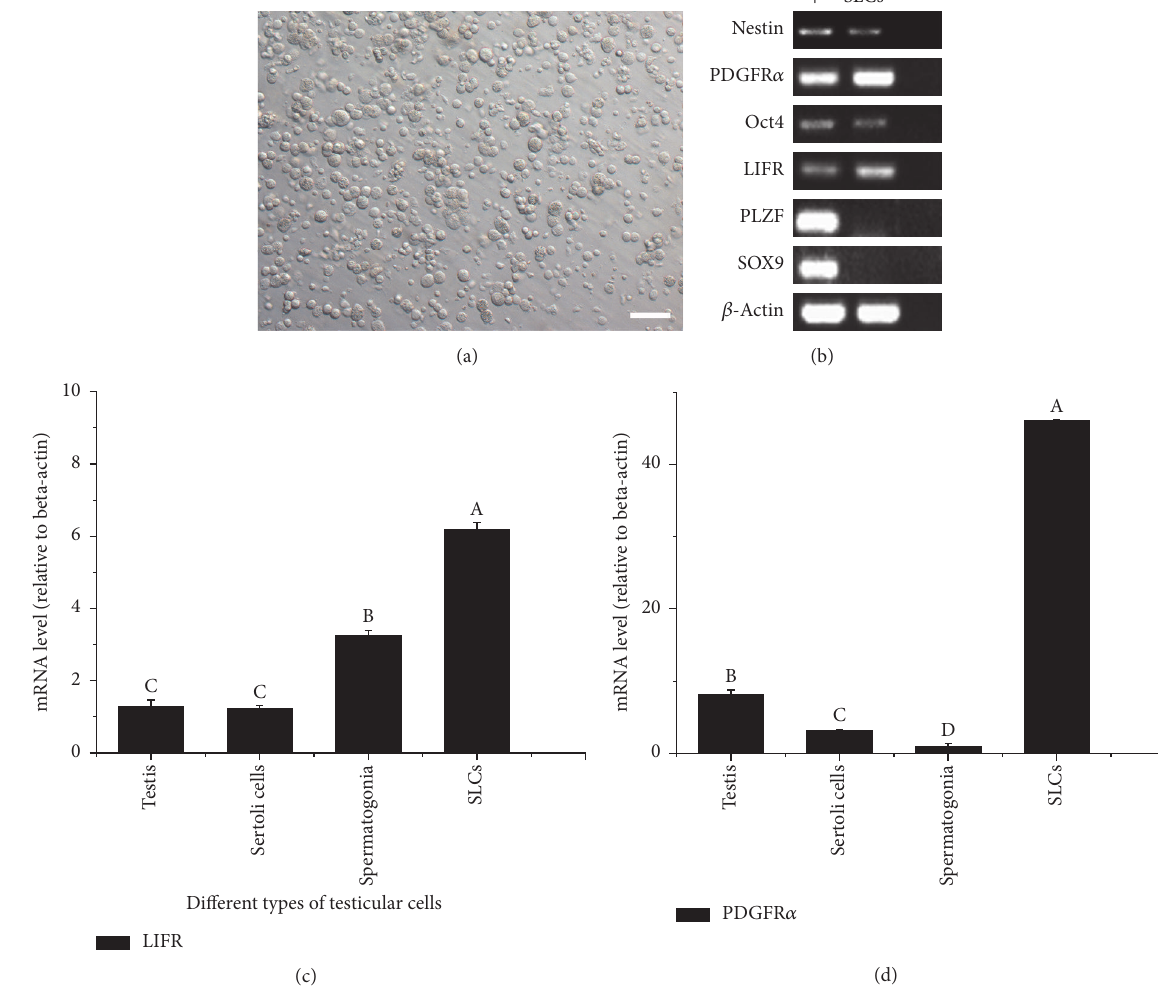
Figure 2: Identification of porcine SLCs. (a) The primary SLCs isolated from 7-day-old porcine testes with the help of collagenase type IV (bar = 50 𝜇 m). (b) RT-PCR results of genes involved in stem cells potential and spermatogenesis; SLCs, the pig primary isolated SLCs; +, positive control (7-day-old pig testes); − , negative control (sterile water). (c and d) Expressions of LIFR and PDGFR 𝛼 in pig testes, pig Sertoli cells, pig Spermatogonia stem cells and pig primary isolated SLCs as fold change relative to beta-actin; Spermatogonia, Spermatogonia stem cells. Different letters (A, B) indicate significant difference ( 𝑃 < 0.05